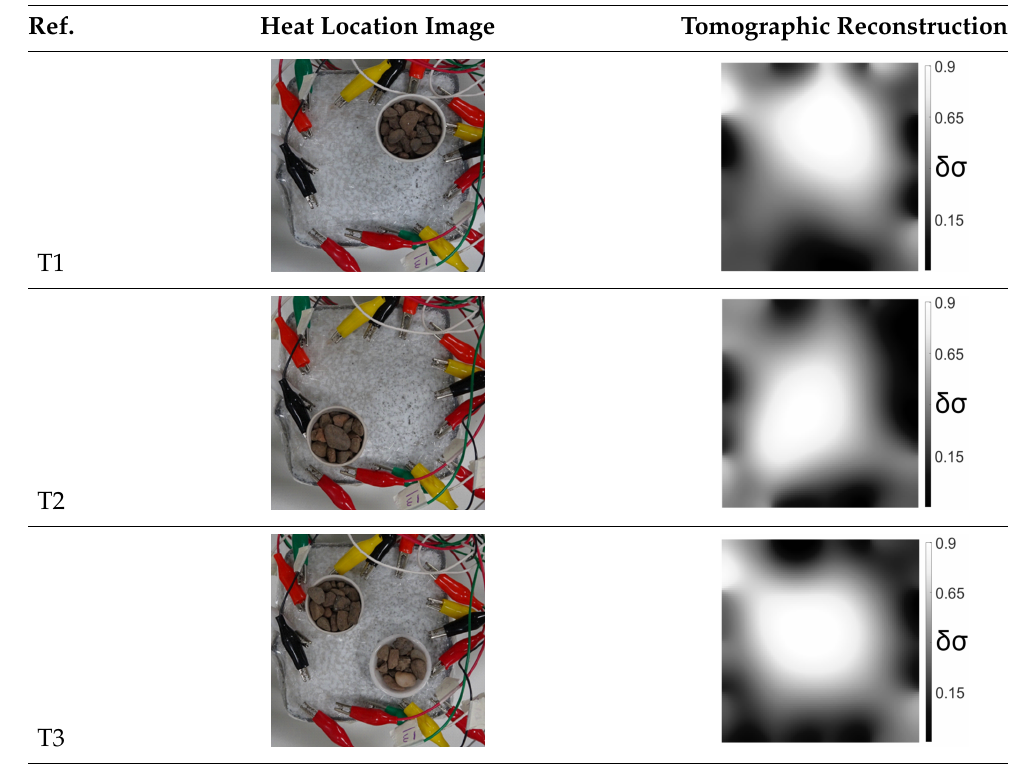
Table 2. Thermal variance detection and localisation results from tomographic reconstruction.